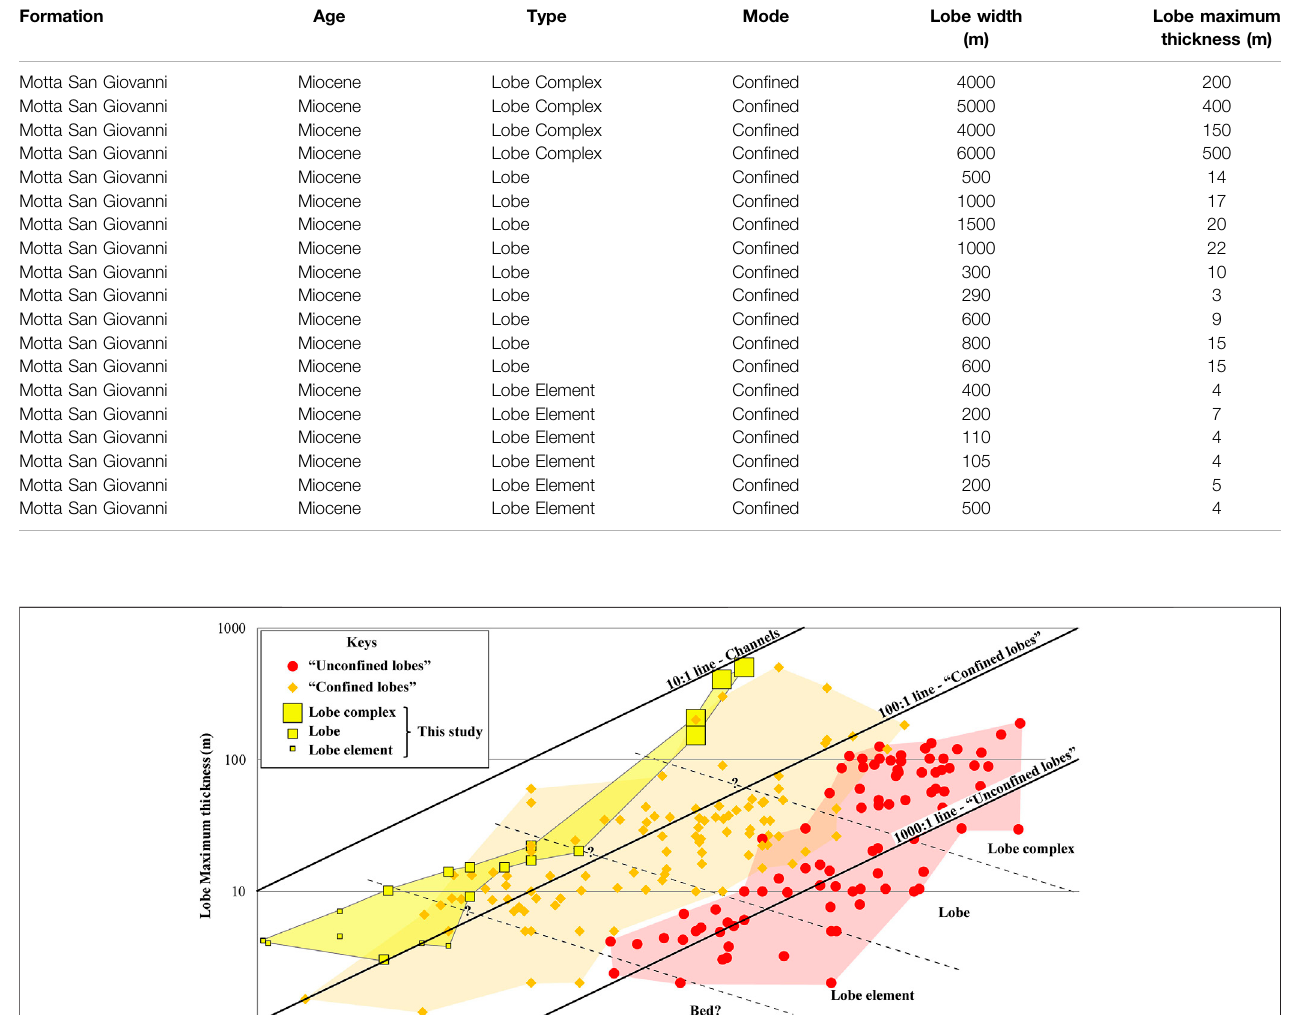
Frontiers in Earth Science |